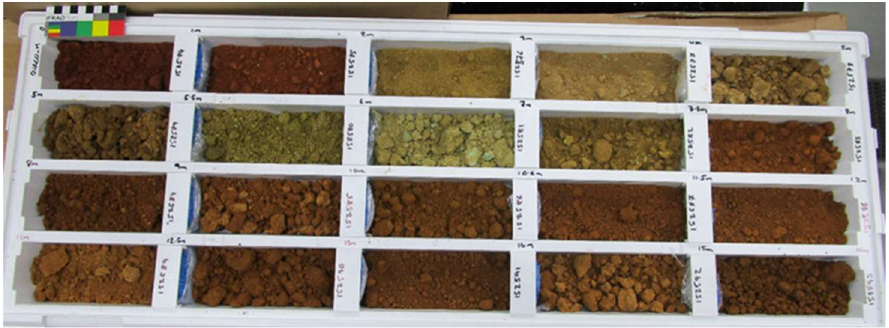
Figure 3. Drill chips from OUACO deposit prepared in a core tray divided into 20 cm compart- ments .